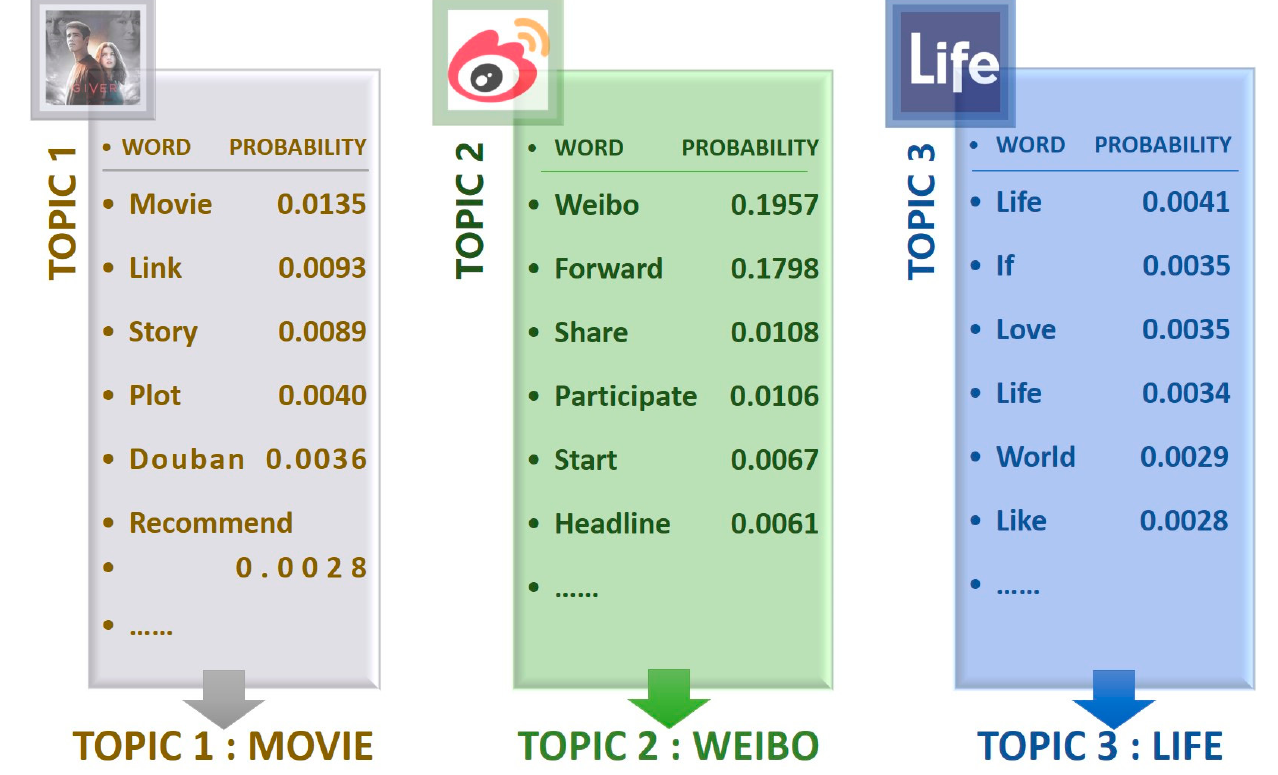
Figure 3. “Words-topic inference file” result example plot.